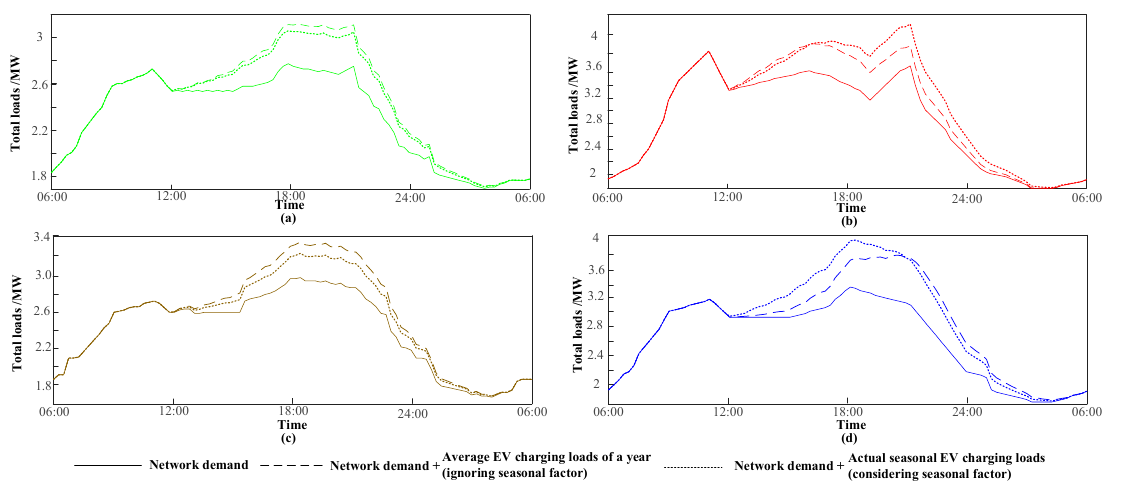
Figure 8. Daily load curves of the given network without considering any optimal charging strategy; ( a ) spring, ( b ) summer, ( c ) autumn, ( d ) winter.